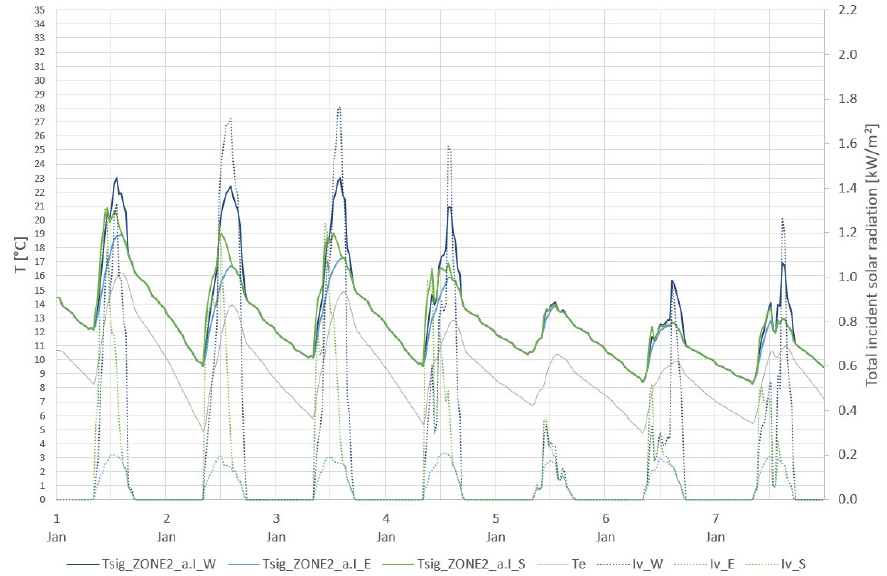
Figure 10. Internal surface temperature of current glazing system for different orientations; winter period: January, first week (floor 2).